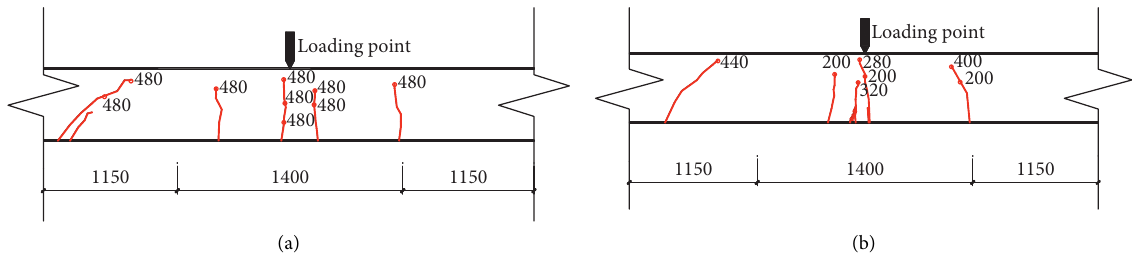
Figure 16: Crack distribution of SC-P4. (a) Crack distribution on Side A and (b) crack distribution on Side